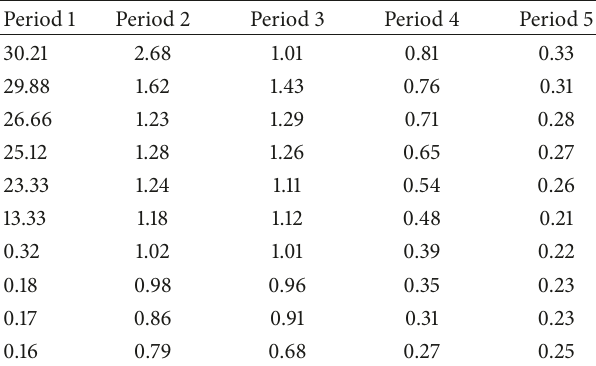
Table 1: Attention values of ten videos with unneglectable